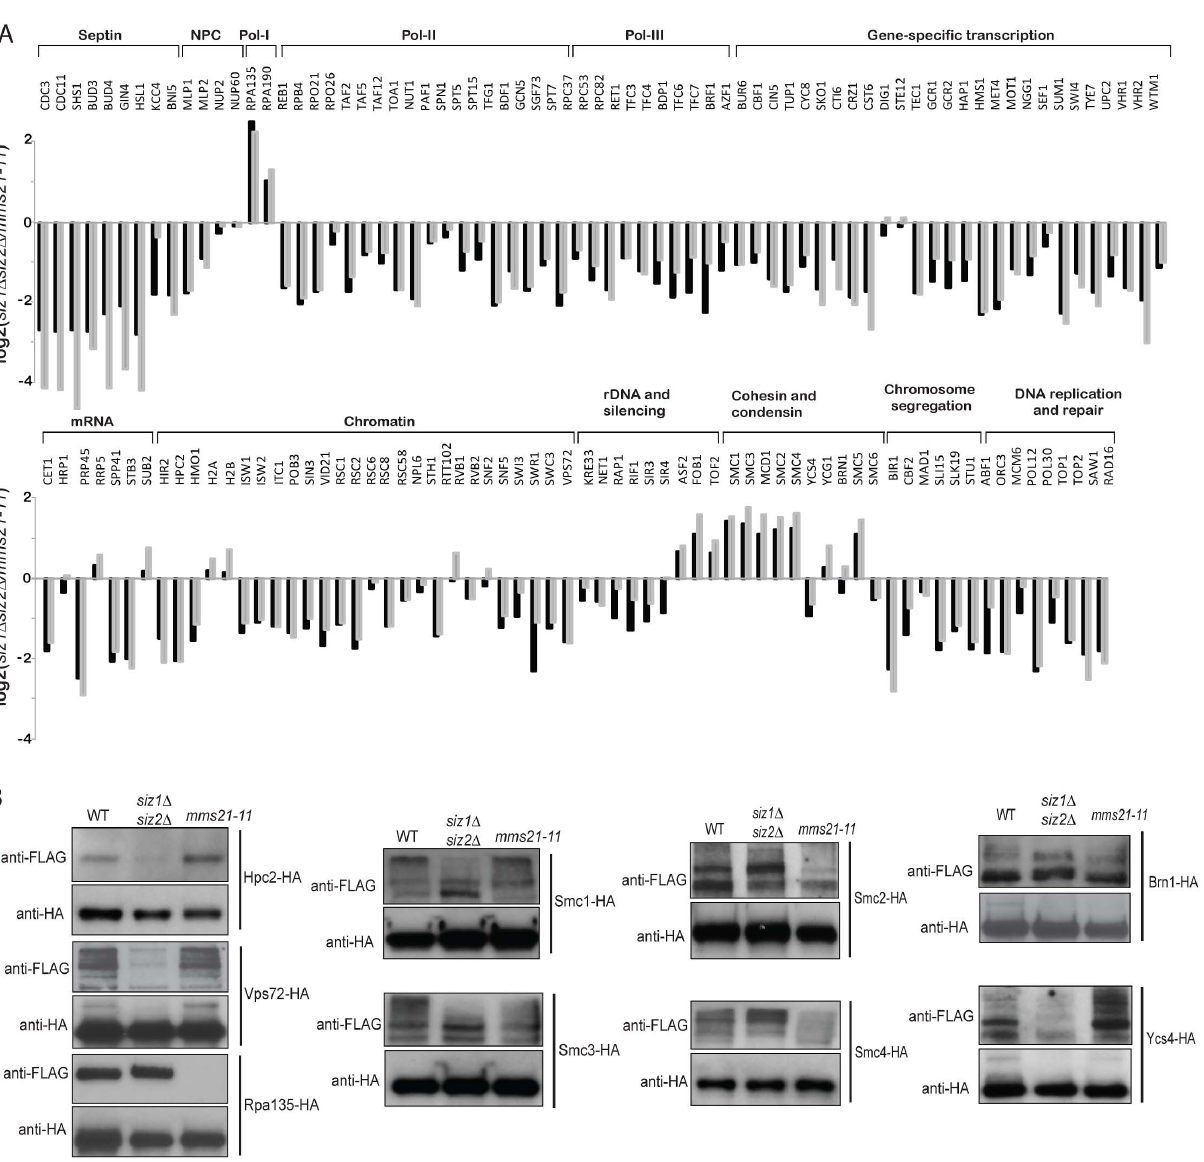
mms21-11 and siz1 D siz2 D mutants using quantitative MS. B) Effects of mm21-11 and siz1 D siz2 D on the sumoylation of selected SUMO targets. Each SUMO target was purified by anti-HA antibody and probed for its sumoylation using anti-FLAG Western